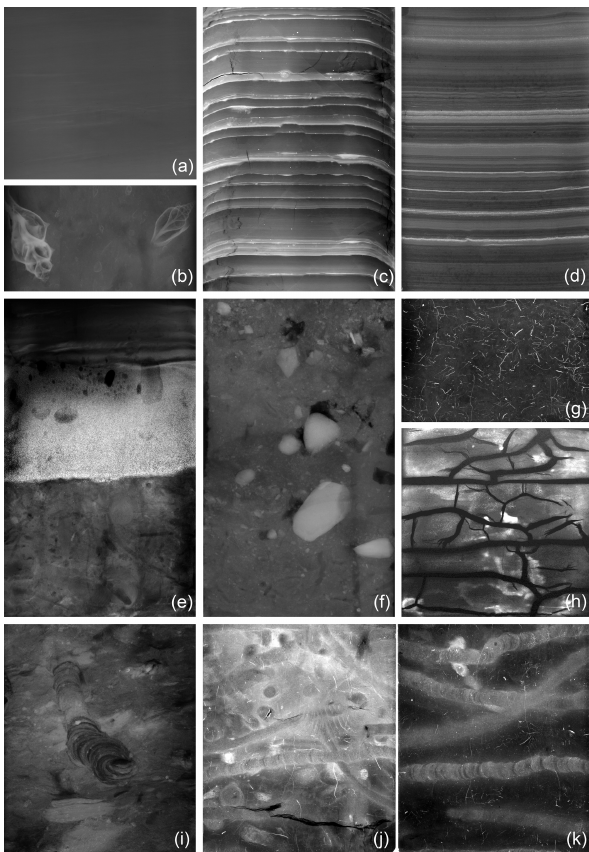
Figure 7. Examples of various X-radiographs from the GIK- Archive. Each has a width of 10cm. (a) Homogeneous clay-like sediment, Mediterranean Sea, https://doi.org/10.1594/PANGAEA. 720925; (b) fossil molluscs, Persian Gulf, https://doi.org/10.1594/ PANGAEA.720253; (c) interbedded strata with artificial down- bending of layers and fault lines as a result of gravity coring, Baltic Sea, https://doi.org/10.1594/PANGAEA.690661; (d) lam- inated sediment, Red Sea, https://doi.org/10.1594/PANGAEA. 720616; (e) turbidite with graded bedding, South China Sea, https: //doi.org/10.1594/PANGAEA.720737; (f) gravel as ice-rafted de- bris, Norwegian Sea, https://doi.org/10.1594/PANGAEA.720368; (g) pyritized lebensspuren, West Atlantic – off Senegal, https:// doi.org/10.1594/PANGAEA.705737; (h) artificial cracks from dry- ing out of an unprotected sediment slab, https://doi.org/10.1594/ PANGAEA.705491; (i, j, k) examples of bioturbation, Baltic Sea off Flensburger Förde, https://doi.org/10.1594/PANGAEA.705626 and African continental slope, https://doi.org/10.1594/PANGAEA.